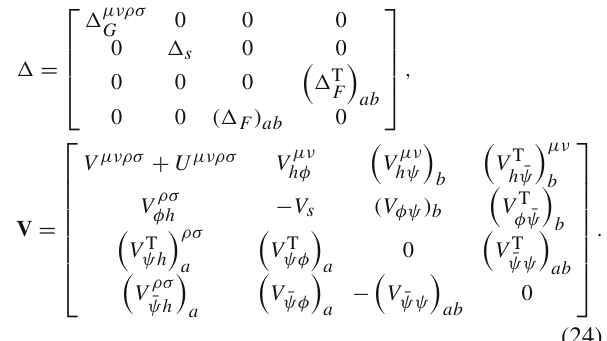
Pulling out (cid:22) from the expression for M allows one to expand the residual expression ( I + (cid:22) − 1 · V ) (where I is a